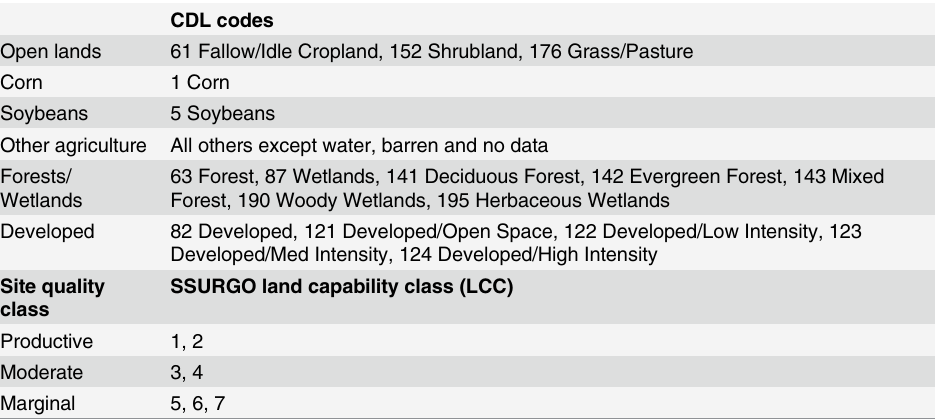
Table 1. Breakdown of the individual Cropland Data Layer (CDL) classes that comprise the land groups used in this